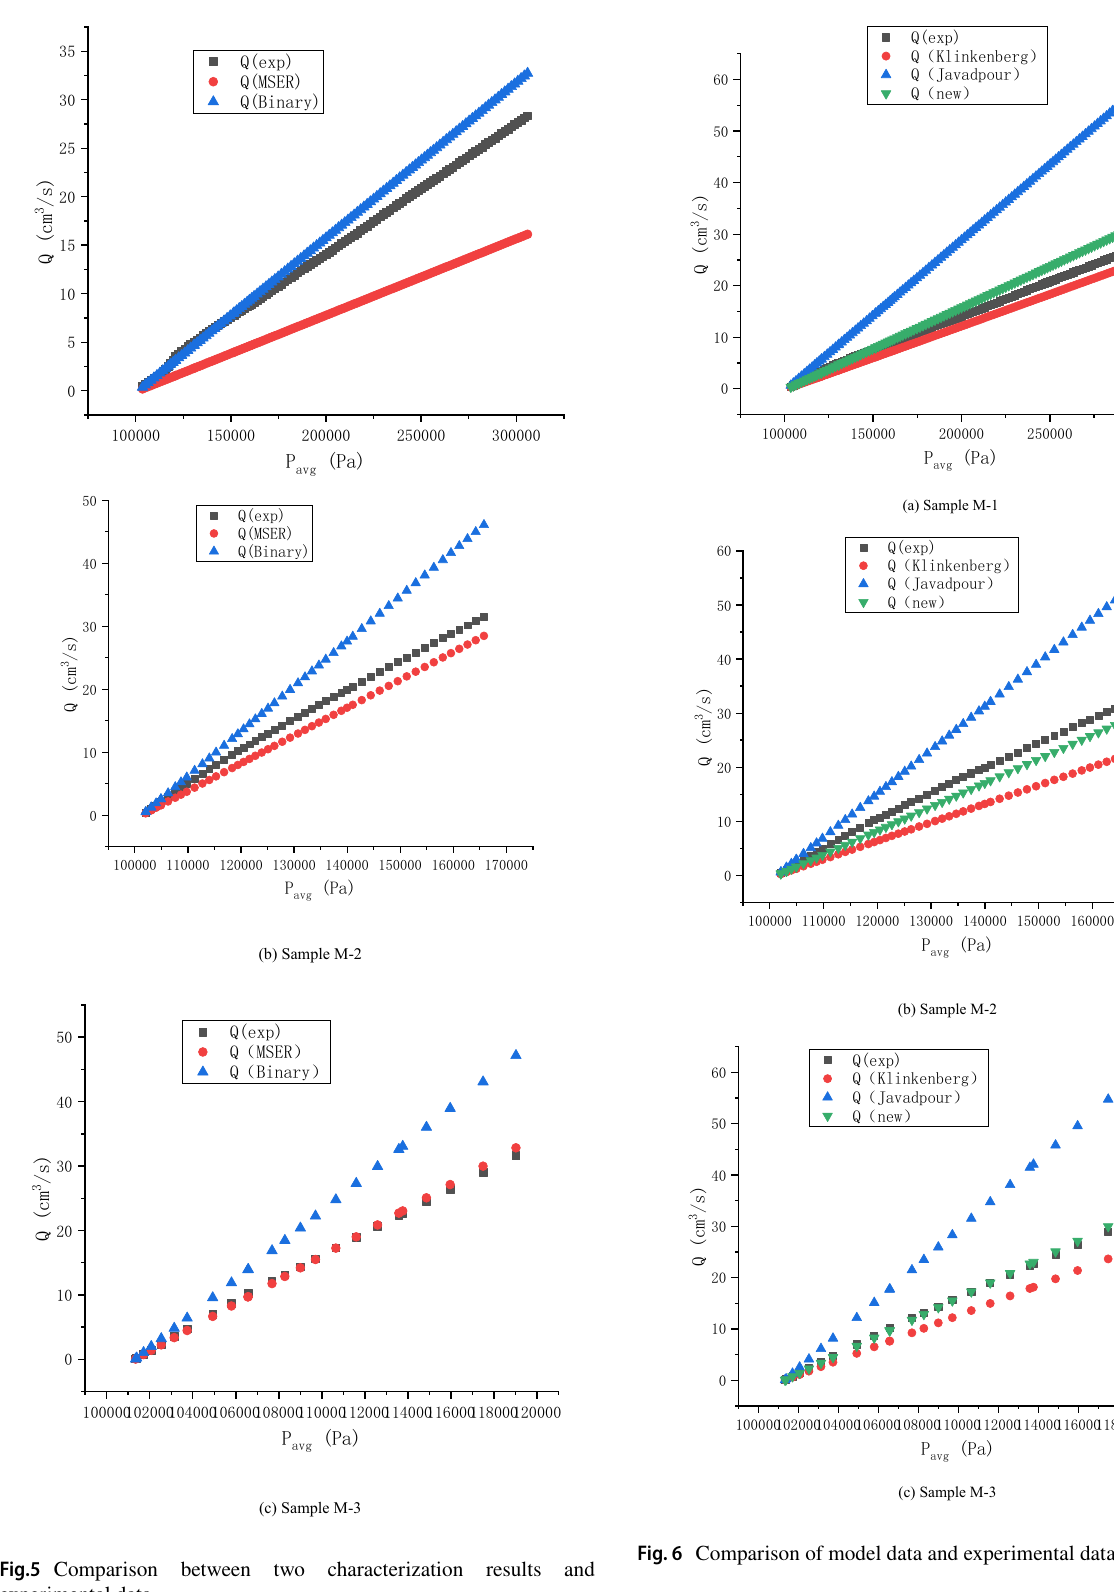
Fig.5 Comparison between two characterization results and experimental data